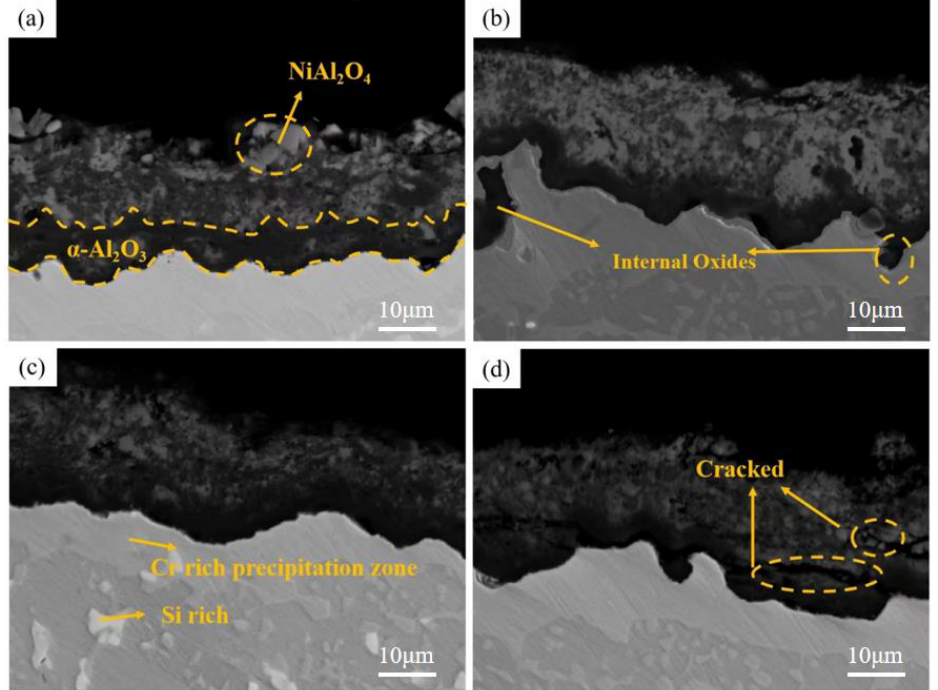
Figure 10. Cross-sectional morphologies of coatings after constant temperature oxidation at 1000 °C for 300 h at different pre-oxidation temperatures: ( a ) untreated; ( b ) 900 °C; ( c ) 950 °C; ( d ) 1000 °C.